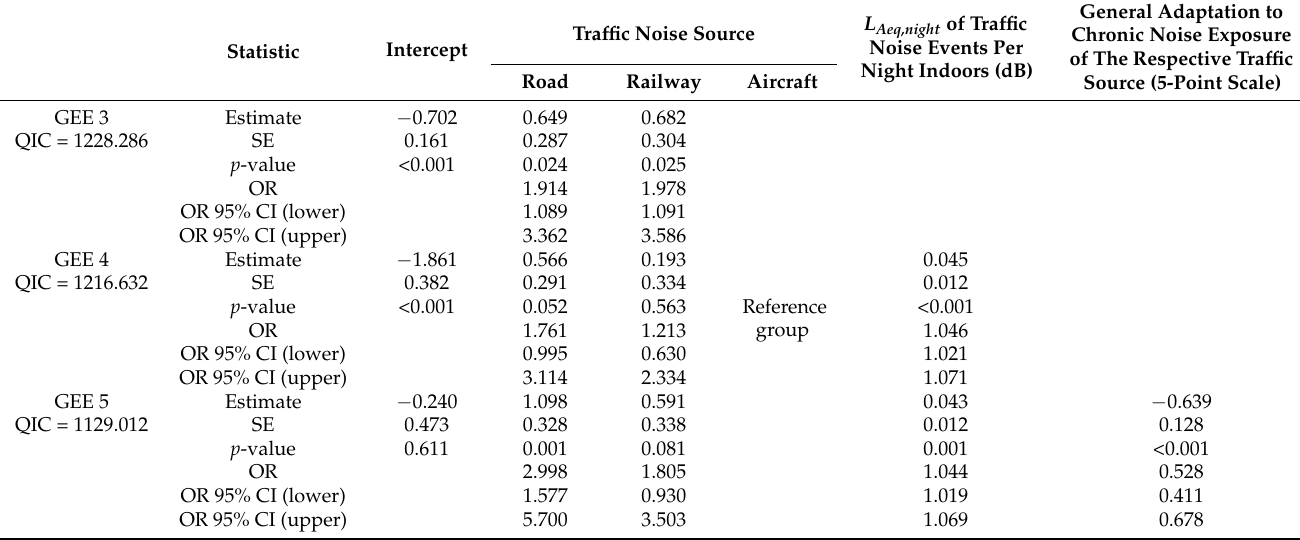
Table 3. Pooled random effects logistic regression calculated stepwise by Generalized Estimating Equation with regard to the effect of the L Aeq,night of road traffic, railway, and aircraft noise measured inside the participants’ bedroom on annoyance: simple model GEE 3, intermediate model GEE 4, and final model GEE 5.